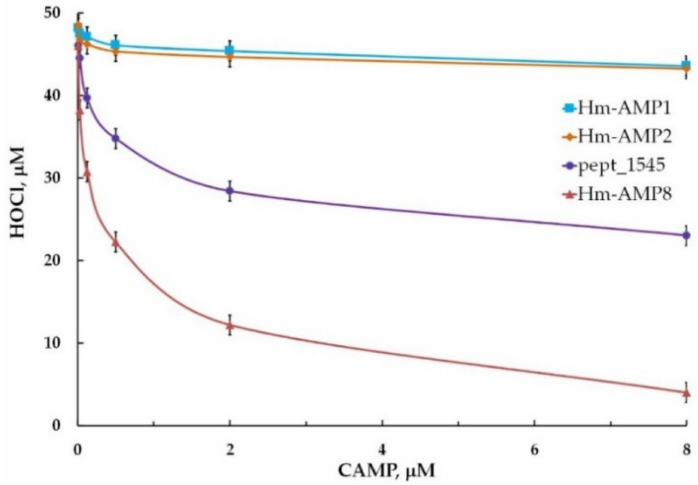
Figure 9. MPO chlorinating activity towards CB and H 2 O 2 in the presence of the cationic antimicrobial peptides Hm-AMP1, Hm-AMP2, pept_1545, and Hm-AMP8 at 0.008–8 µ M (peptide/heme molar ratios from 10 to 10,000). The concentrations were as follows: 0.8 nM MPO heme, 200 µ M CB,